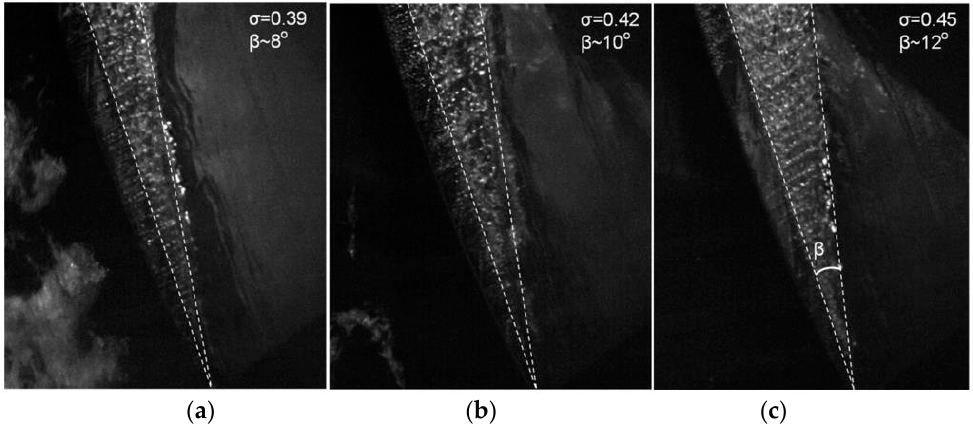
Figure 11. High-speed video images of cavitation pattern with different cavitation number [24]. ( a ) σ = 0.39; ( b ) σ = 0.42; ( c ) σ = 0.45. σ : cavitation number; β : apex angle.